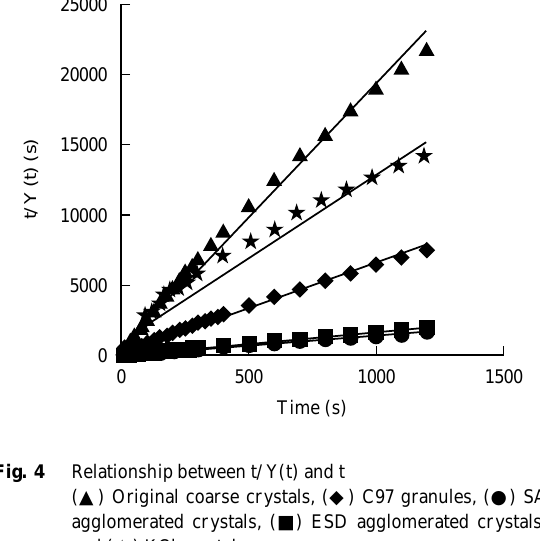
Fig. 4 Relationship between t/Y(t) and t ( ▲ ) Original coarse crystals, ( ◆ ) C97 granules, ( ● ) SA agglomerated crystals, ( ■ ) ESD agglomerated crystals, and ( ★ ) KCl